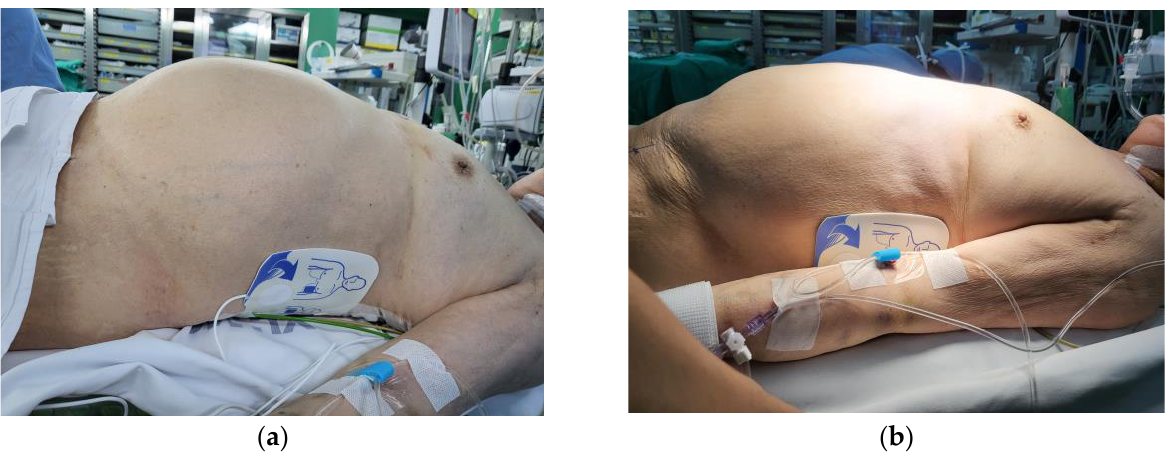
Figure 2. ( a ) The patient’s abdomen became distended. ( b ) The patient’s abdomen became soft and flat after the tube thoracotomy.